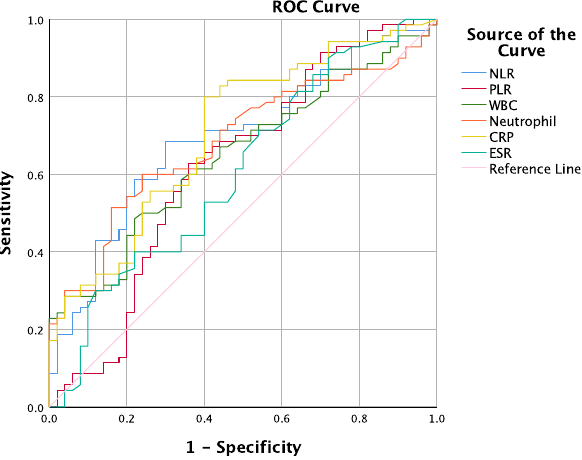
Figure 1: ROC analysis graphic of laboratory measurements of the patients. ROC, receiver operator curve; AUC, area under curve; WBC, white blood cell; PLT, platelet; ESR, erythrocyte sedimentation rate; CRP, C-reactive protein; NLR, neutrophil/lymphocyte ratio; PLR, platelet/lymphocyte